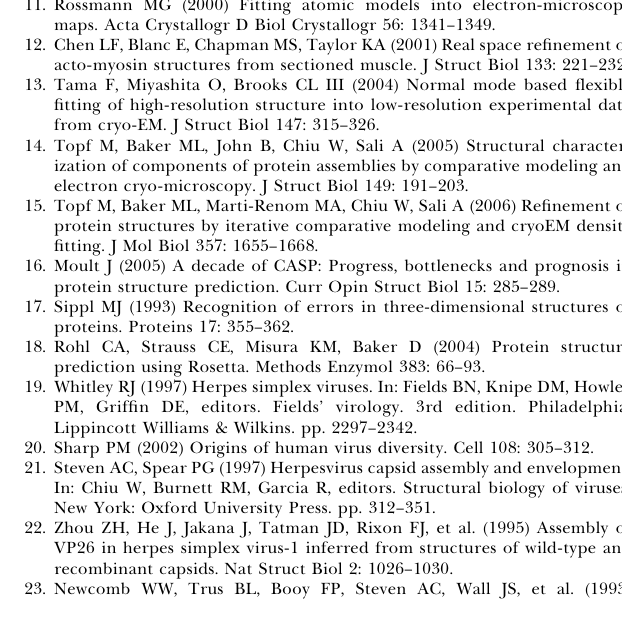
Found at DOI: 10.1371/journal.pcbi.0020146.sg002 (1.3 MB PDF). Figure S3. VP26 Core Domain Decoys